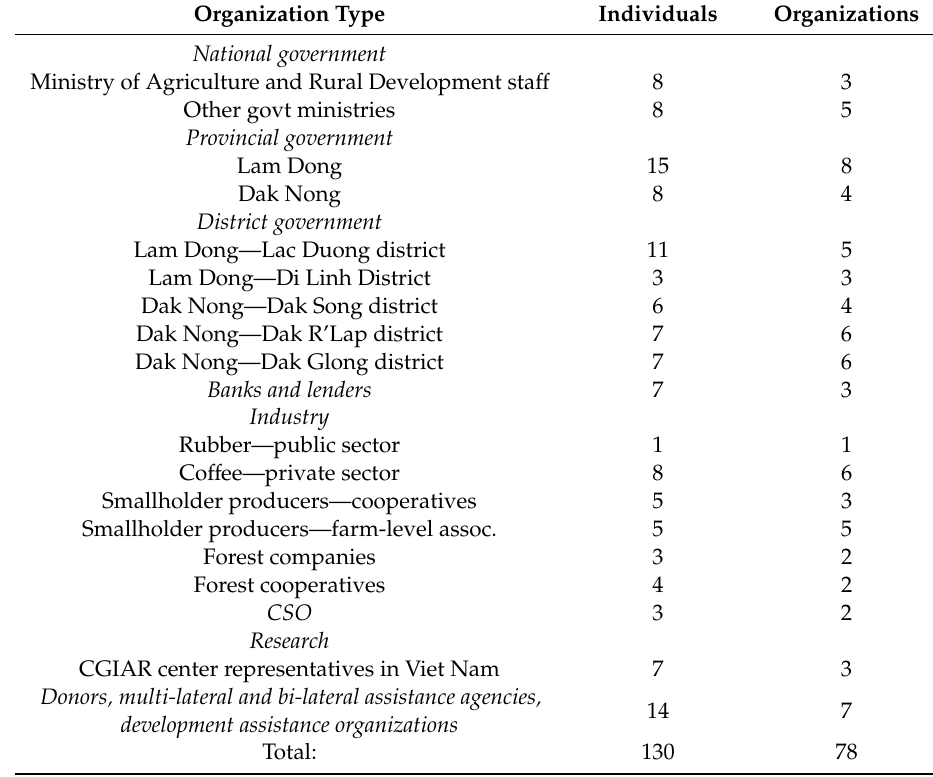
Table 1. Summary of